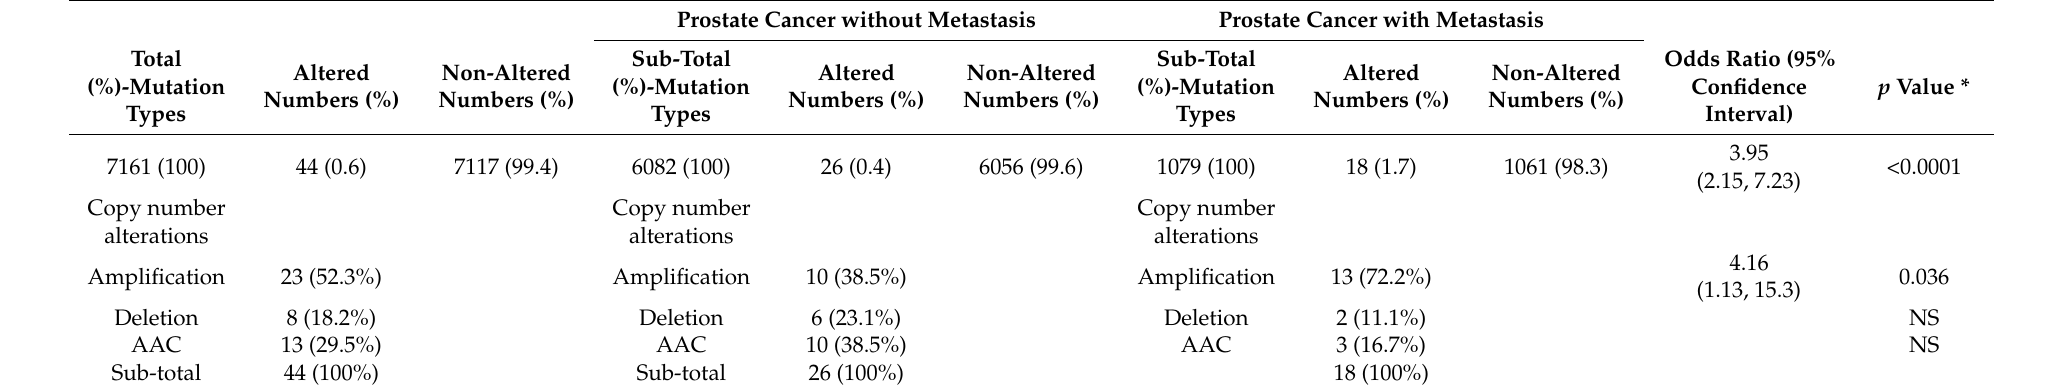
Table 1. Association between hepsin genomic alterations and metastasis in prostate cancer. Prostate Cancer without Metastasis Prostate Cancer with